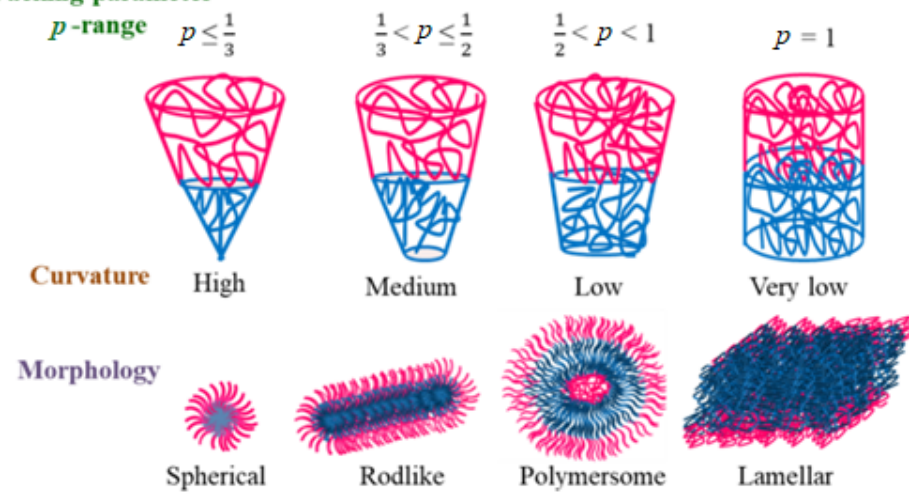
Figure 6. Different block copolymer self-assembly as a function of packing parameter p -range.